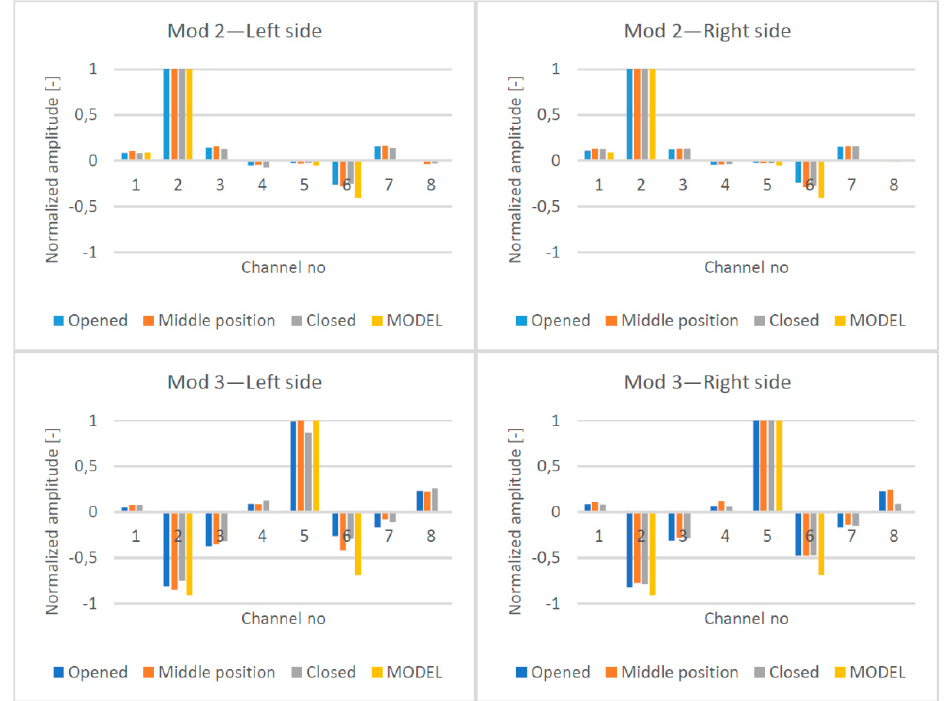
Figure 15. Comparison of the normalized eigenforms identified in three different positions of the gate’s leaves for the two identified mods. Yellow bars represent corresponding results from the numerical model.